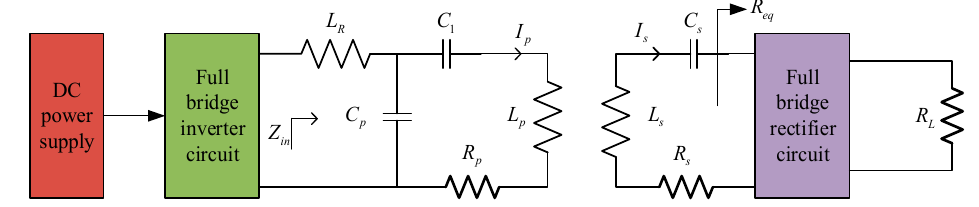
Figure 4. Circuit topology principle of contactless excitation motor. R eq is the equivalent resistance after full-bridge rectification, ignoring the loss of the rectifier. In the primary circuit, there are two resonant circuits, which are the resonant circuit composed of the